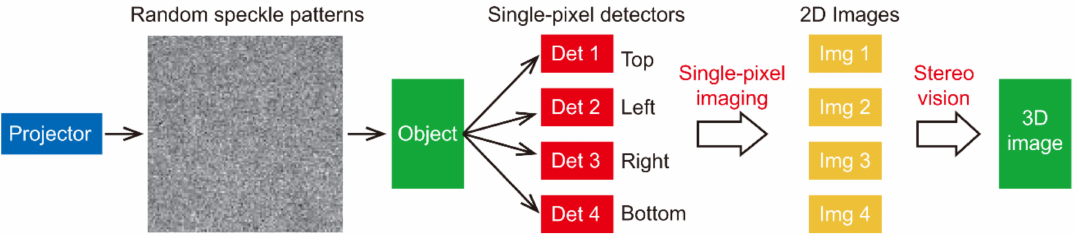
Figure 5. Schematic of a stereo vision based 3D single-pixel